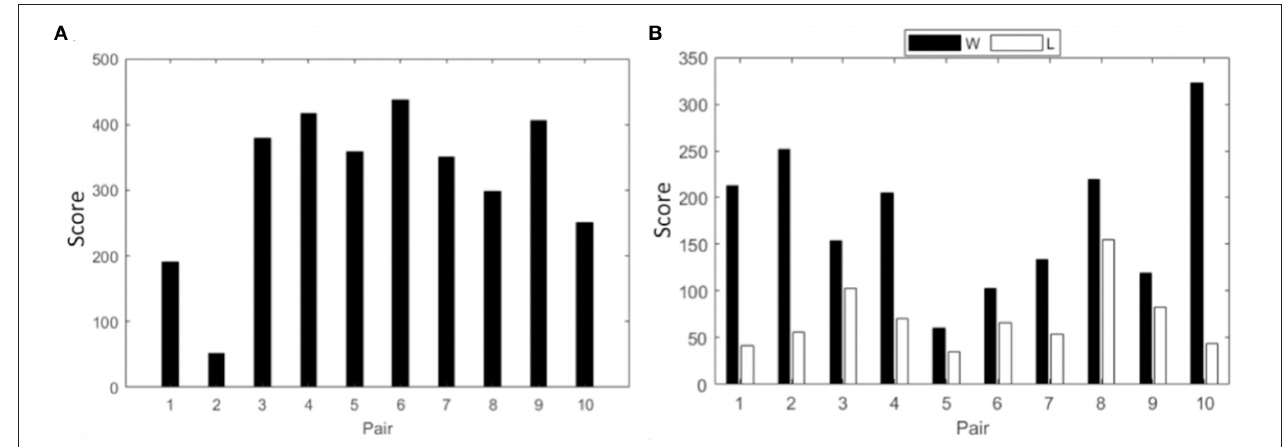
FIGURE 2 | Cumulative score of all pairs from session three in (A) collaborative gaming; (B) competitive gaming, winners (black) and losers (white).